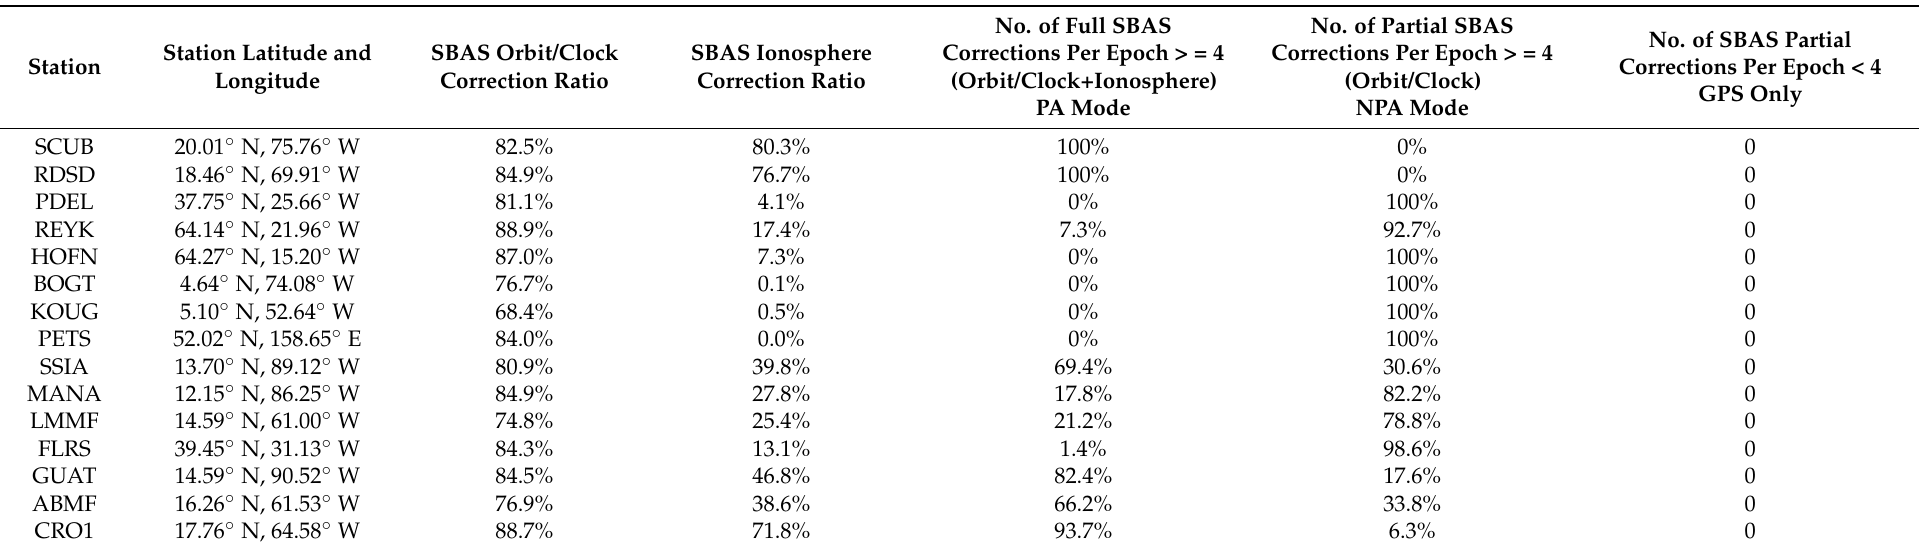
Table 2. WAAS correction and positioning mode availability at IGS global navigation satellite system (GNSS) stations in March